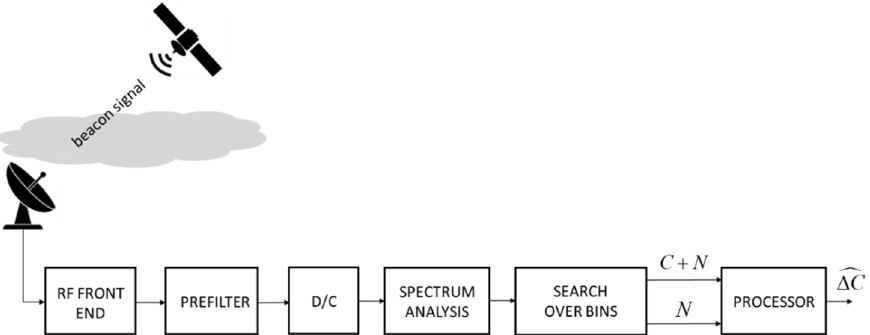
Figure 6. High-level block diagram of a beacon receiver for the estimate of the carrier attenuation.